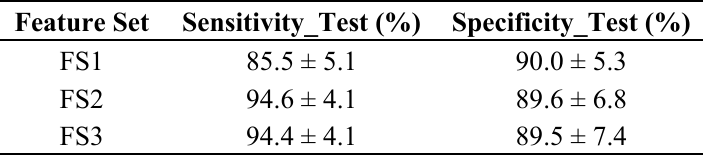
Table 8. Sensitivity and specificity of the pseudo-two-class classification